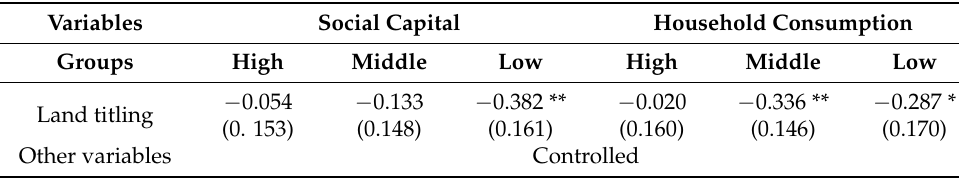
Table 4. The estimation results in the group regression.